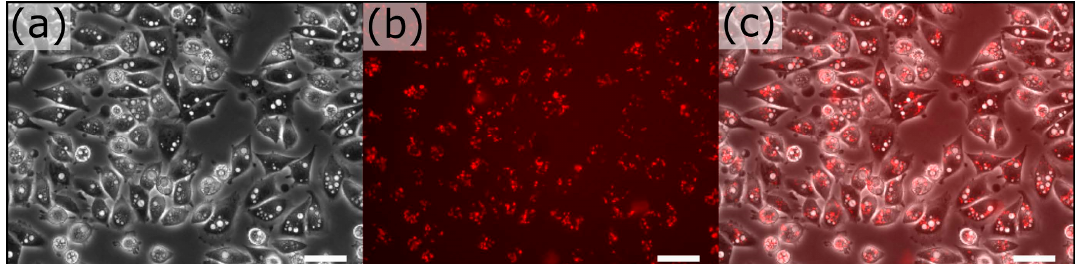
Figure 2. Bacterial delivery of violacein at MOI of 25 at 4 h post-infection. ( a ) Phase contrast image exhibits the formation of large vacuoles within most cells; ( b ) Red channel exhibits invasive bacteria that harbor a RFP reporter; ( c ) Overlay indicates an abundant number of internalized bacteria for downstream retrieval. Scale bar represents 50 μ m.